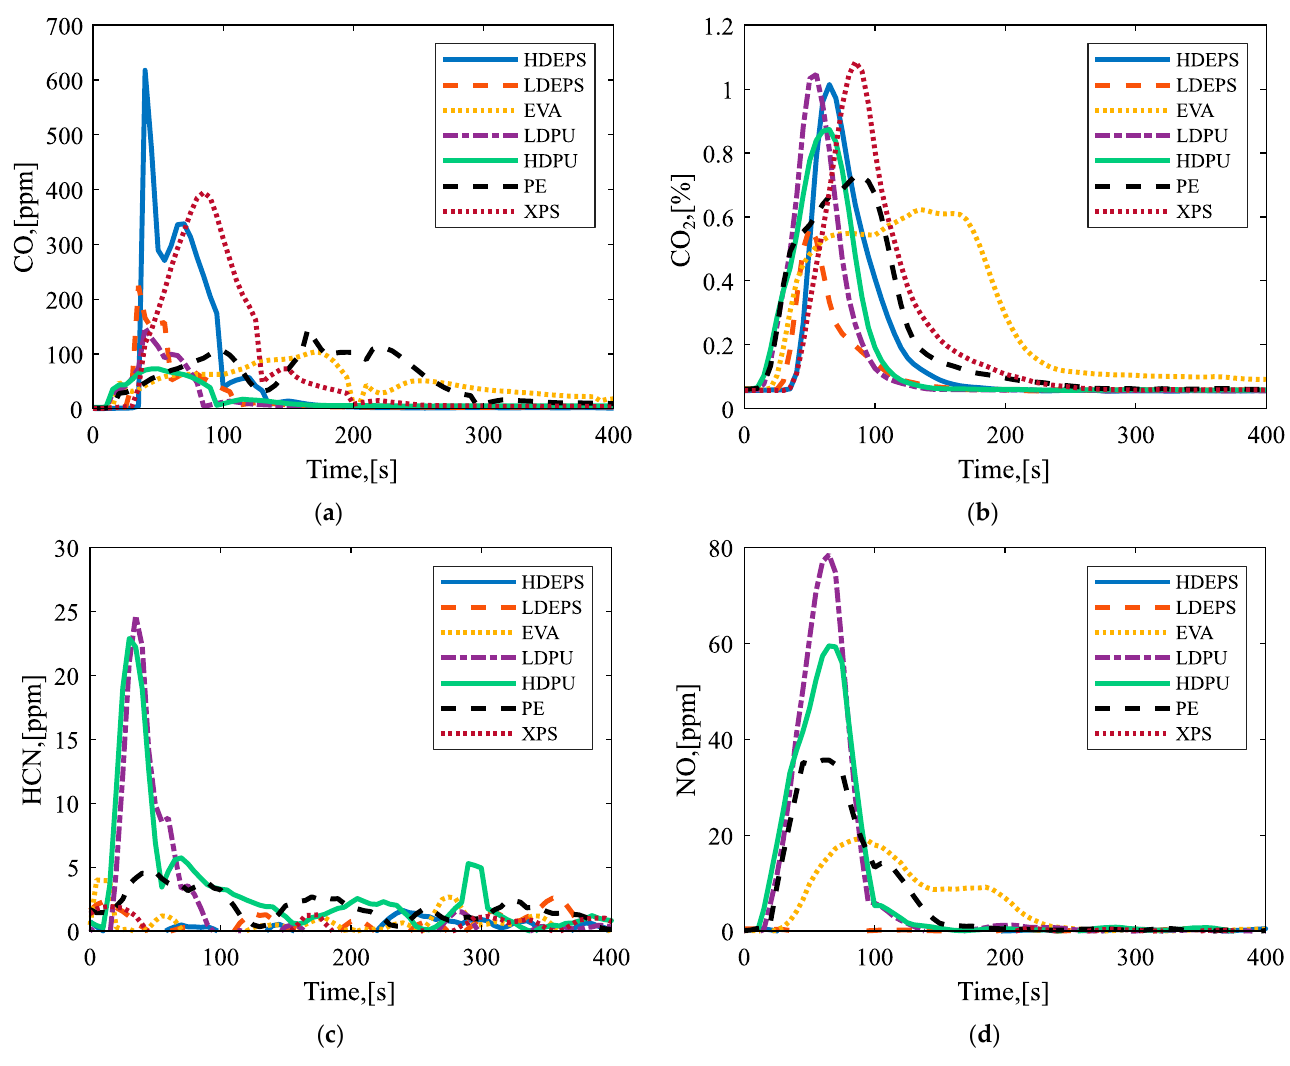
Figure 7. Concentrations of toxic gas emissions as a function of time at 50 kW/m 2 heat flux. ( a ) CO; ( b ) CO 2 ; ( c ) HCN; ( d ) NO.